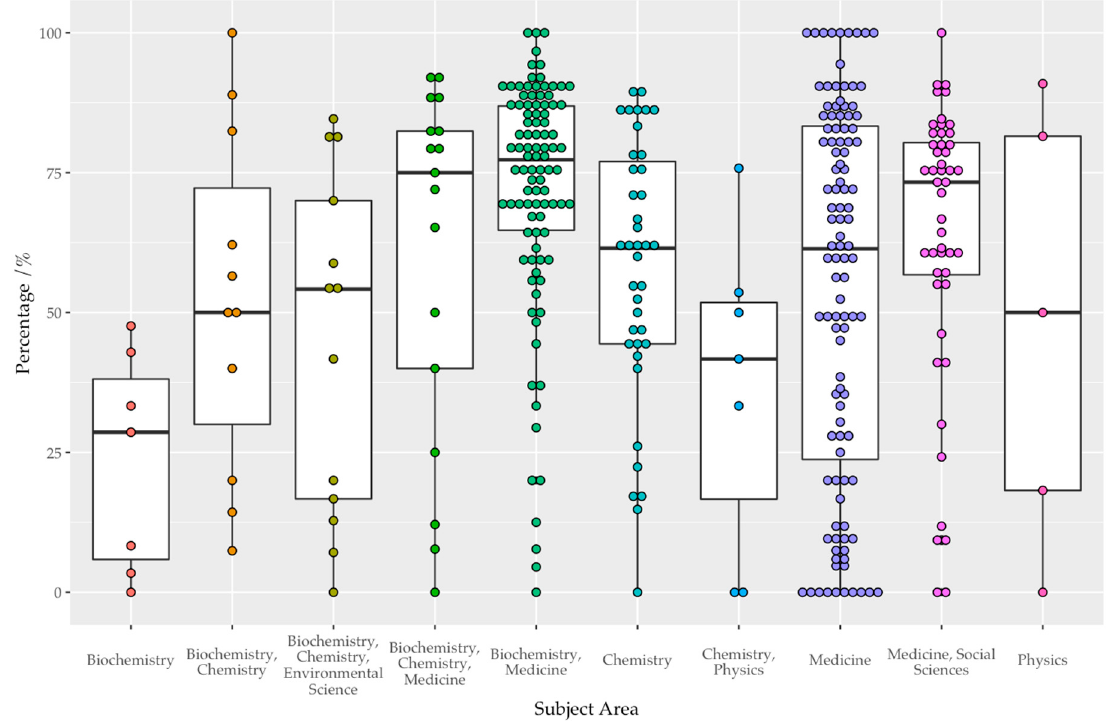
Figure 4. Percentage of citation per subject area already present with the original search. As of September 2019, only publications with 5 or more citations were selected (n = 413). Of the 413 records, 2 had been citated only in publications dating from 2018.